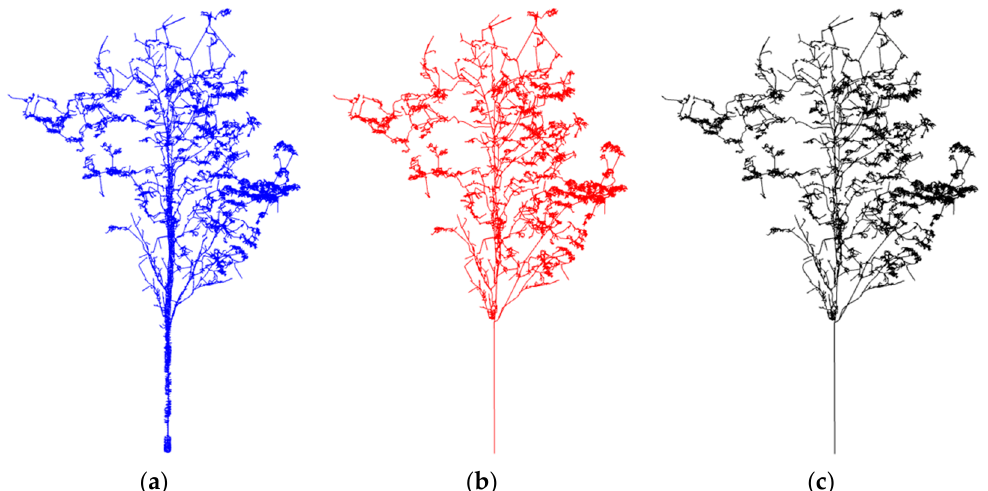
Figure 4. Skeleton initialization and simplification. ( a ) Initial skeleton; ( b ) simplified the initial skeleton; ( c ) final skeleton.